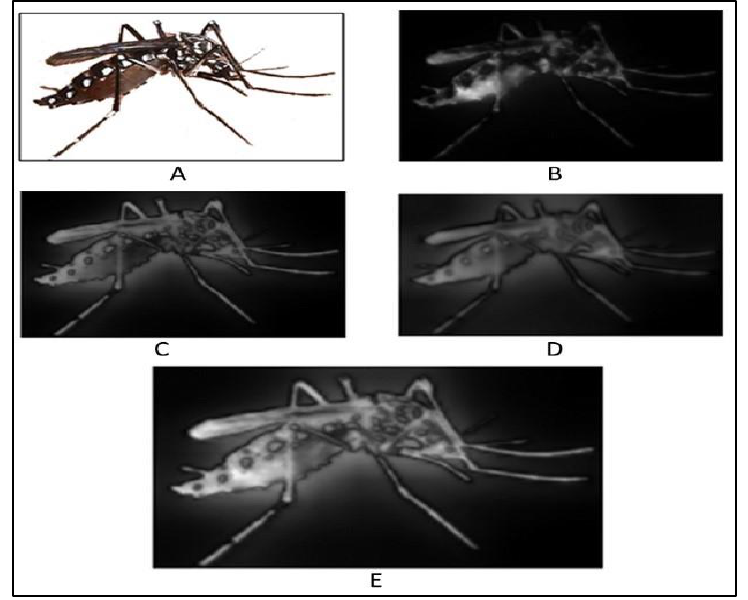
Figure 3. The saliency map generation from an input image ( A ), the color map ( B ), intensity map ( C ), and the orientation map ( D ) are combined to obtain the saliency map ( E ).